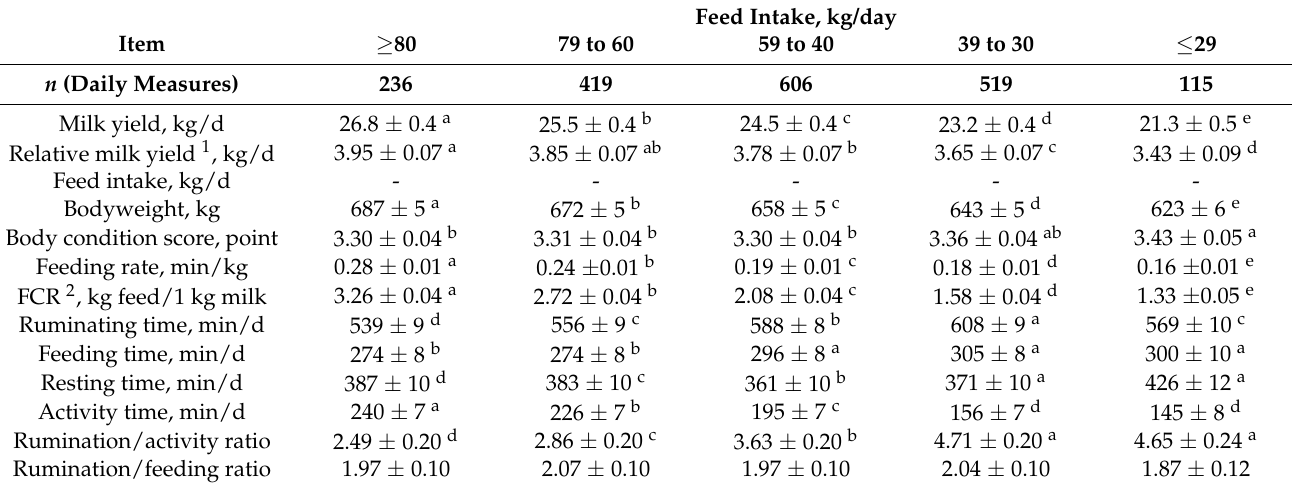
Table 3. Effects of feed intake on evaluated variables.